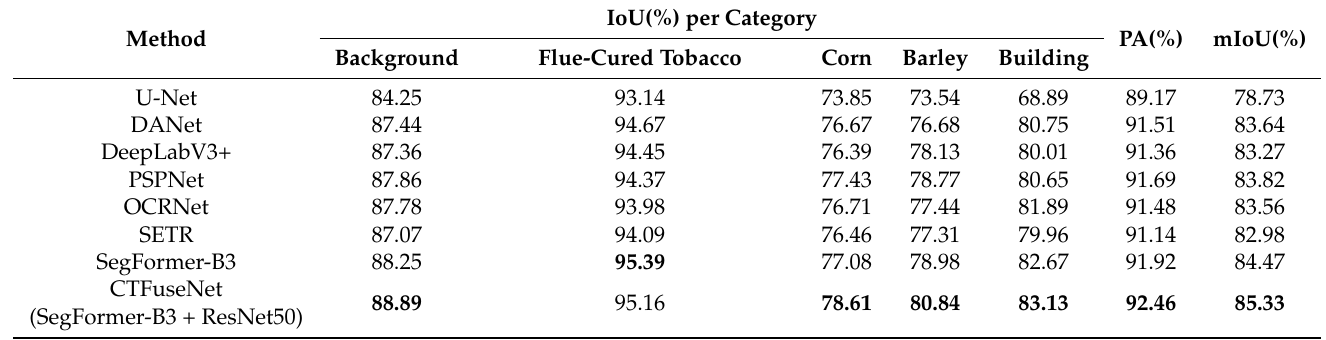
Table 2. Performance comparison of crop-type segmentation networks. The best results are in